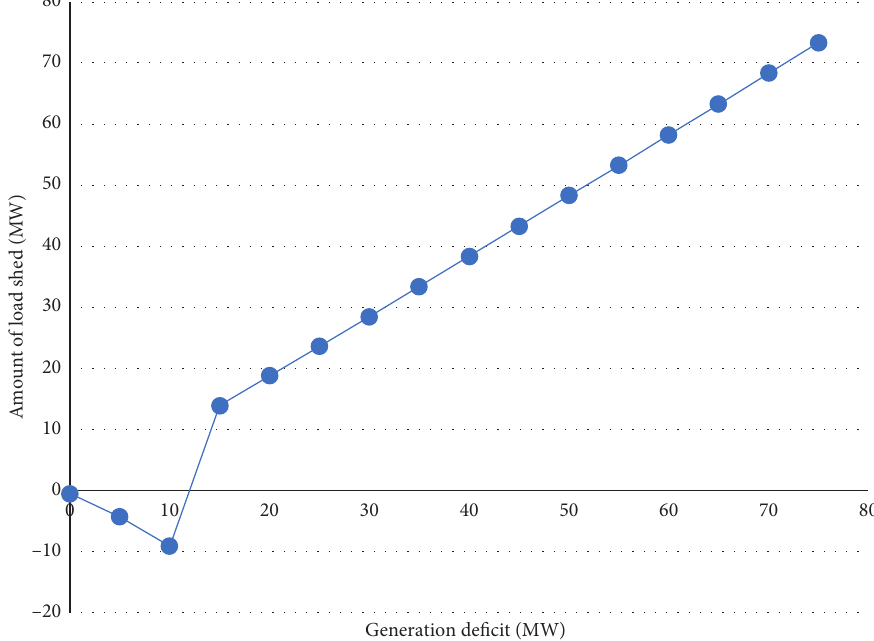
Figure 4: Load to shed versus generation deficit.